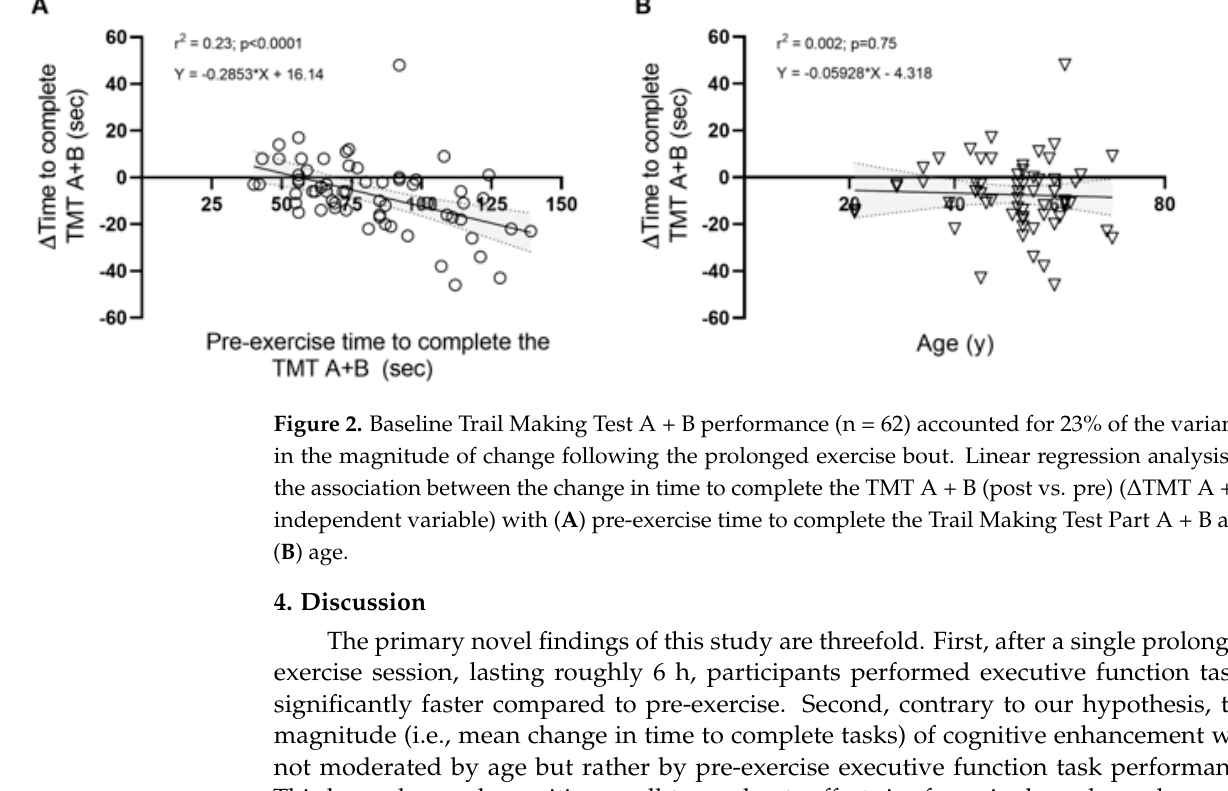
Figure 2. Baseline Trail Making Test A + B performance (n = 62) accounted for 23% of the variance in the magnitude of change following the prolonged exercise bout. Linear regression analysis of the association between the change in time to complete the TMT A + B (post vs. pre) ( ∆ TMT A + B;